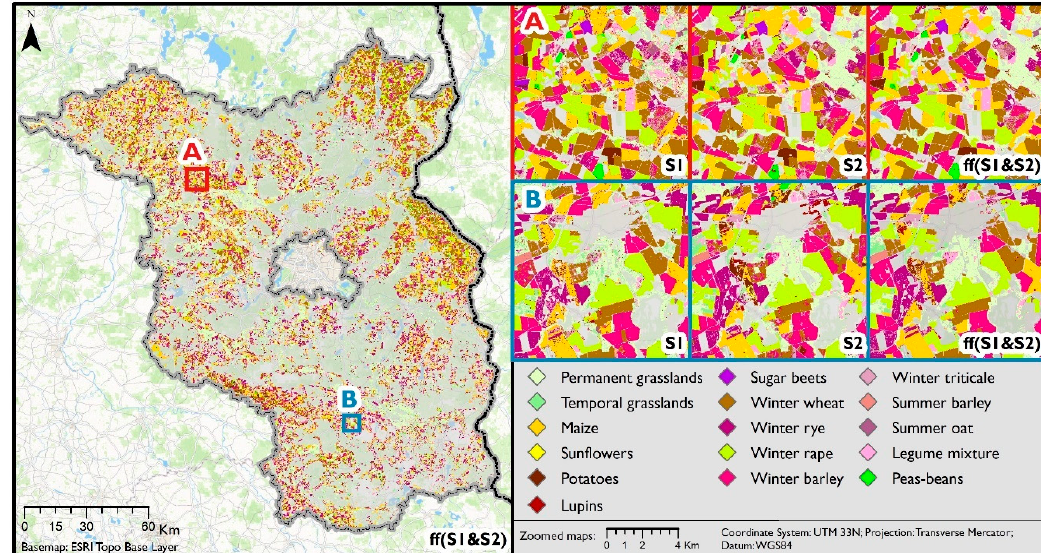
Figure 8. Classification maps based on only SAR (S1) features, only optical (S2) features, their combination (ff(S1&S2)).